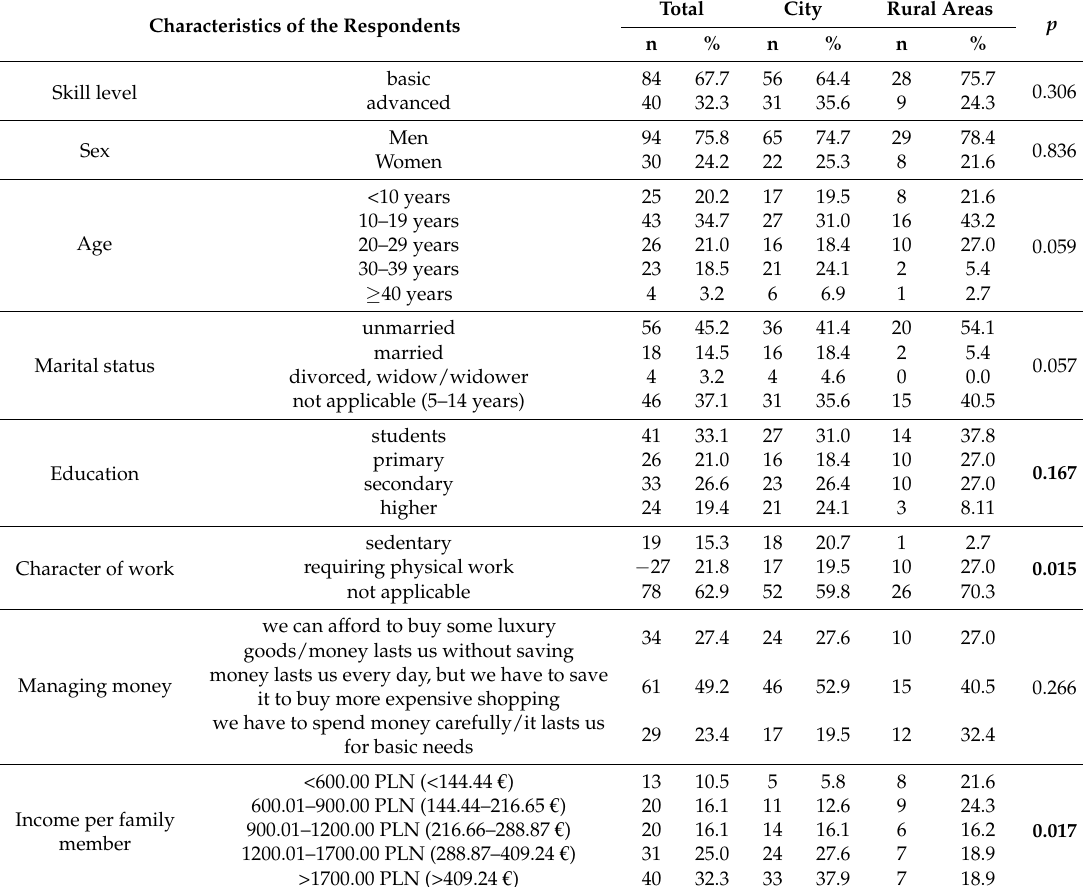
Table 3. Characteristics of Poles (n = 124) who reported practicing combat sports in the period studied (either professionally or recreationally) depending on their place of residence (cities/rural areas) and significance of differences based on the chi–squared